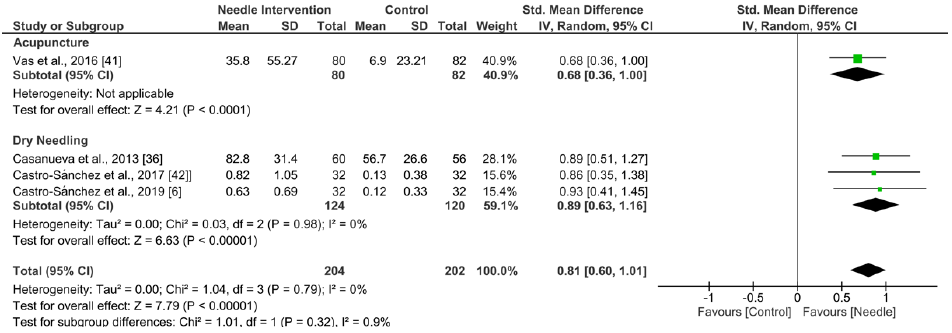
Figure 12. Forest plot for